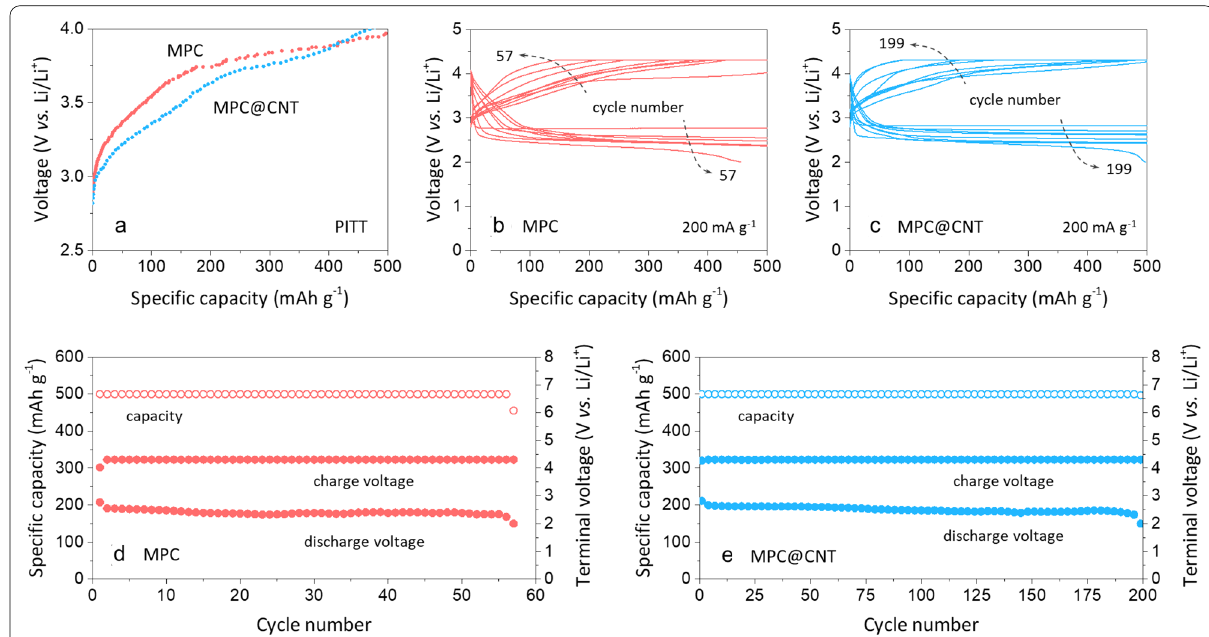
Fig. 4 a Quasi‑equilibriium charge potential profiles of the LOBs with MPC and MPC@CNT obtained via PITT experiments. Discharge–charge curves of the LOBs with b MPC and c MPC@CNT during cycling at 200 mA g − 1 . Plots of capacity and terminal (discharge/charge) voltages against the cycle number for the LOBs with d MPC and e